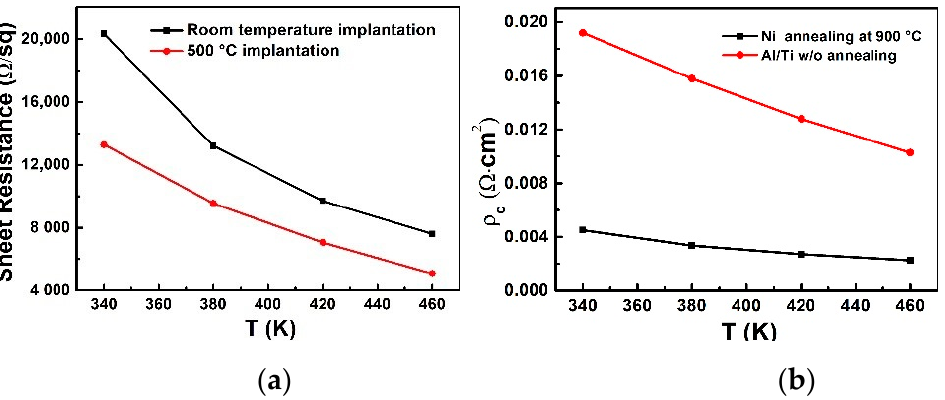
Figure 11. ( a ) The P-region sheet resistance tested at elevated temperature ( b ) the P ohmic contact resistance tested at elevated temperature.